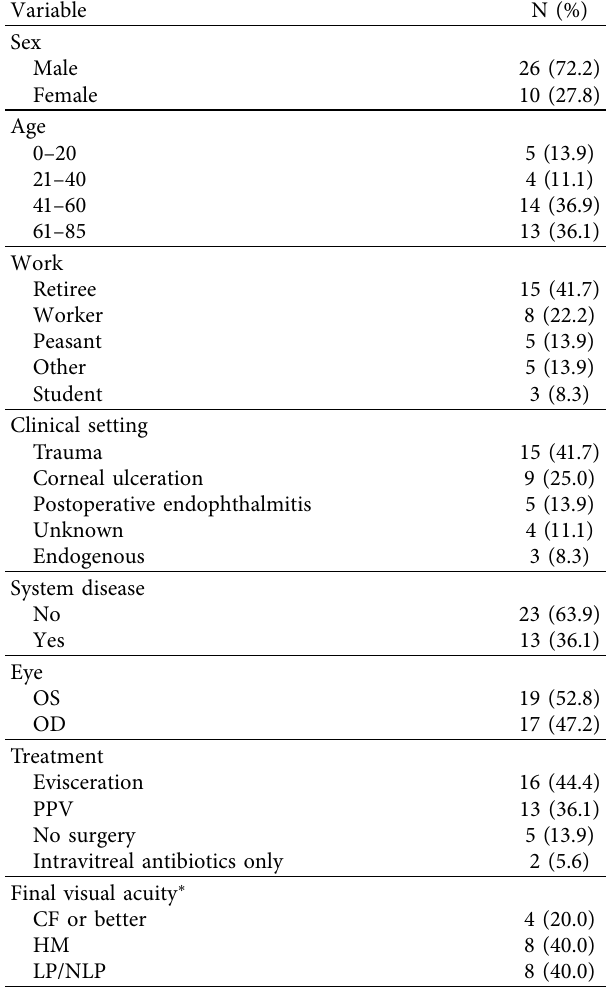
Table 2: Summary of the 36 patients with Pseudomonas aeruginosa endophthalmitis.